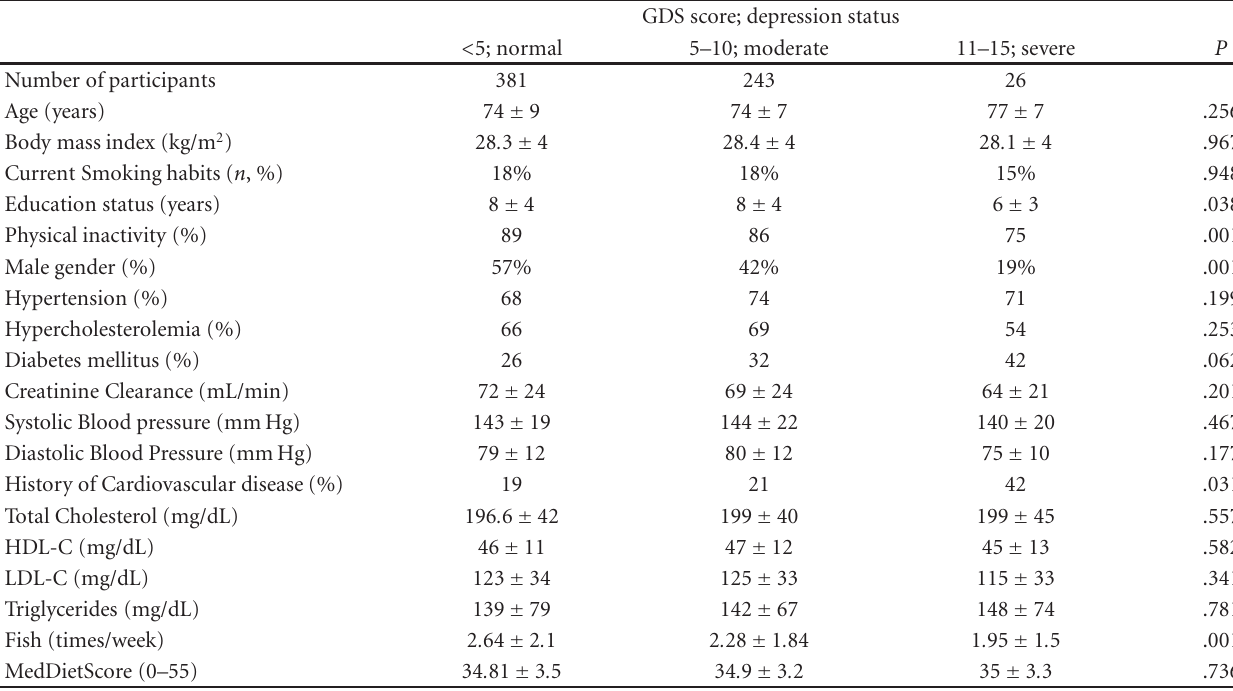
Table 3: Demographic, behavioral, and clinical characteristics, by depression status.